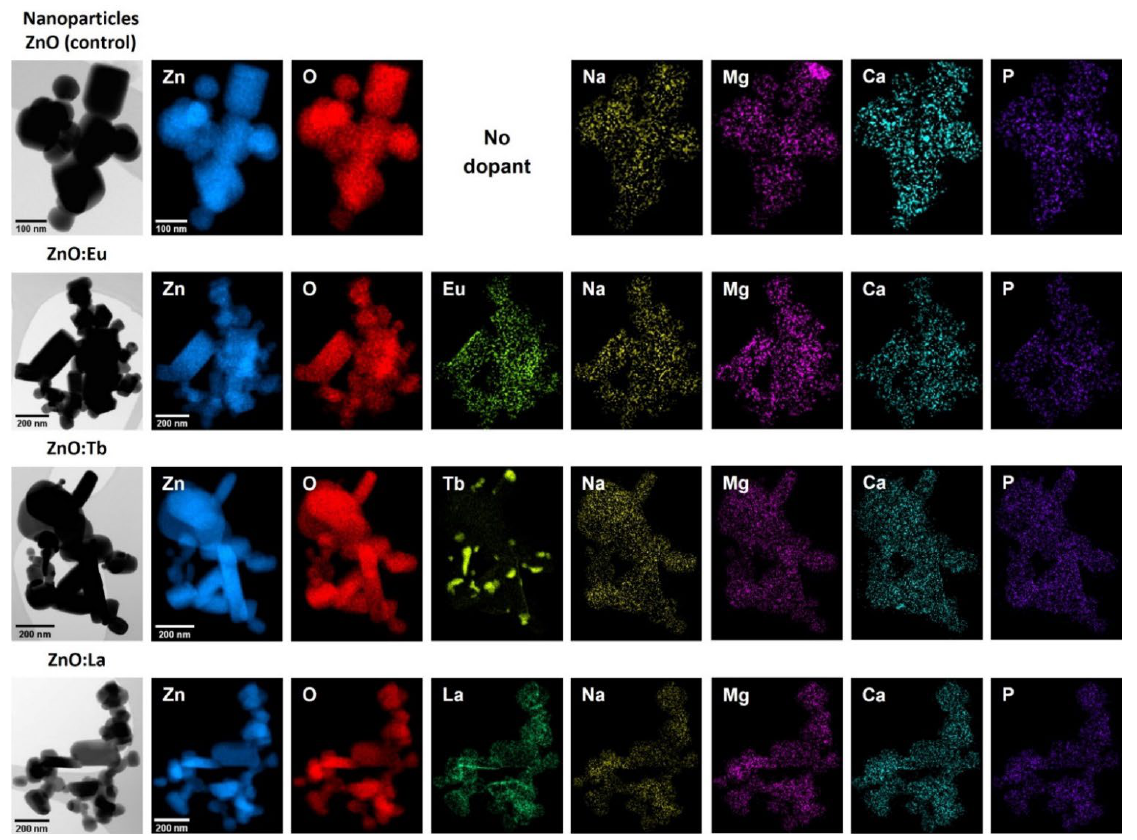
Figure 3. STEM images along with EDS elemental maps of undoped ZnO nanoparticles (control) and ZnO NPs doped with lanthanides (Eu, Tb and La).